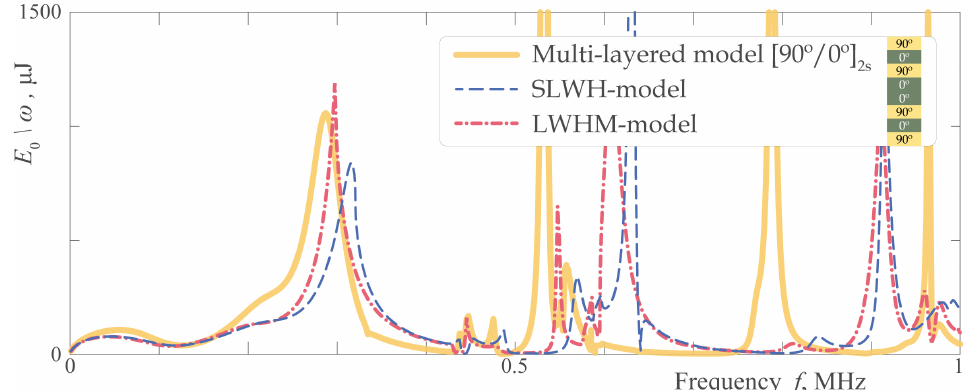
Figure 12. The wave energy transferred into the waveguide E 0 ( f ) by the PWT on the surface of multi- layered waveguide [ 90 ◦ ,0 ◦ ] 2s (thick solid line), and waveguides with effective properties estimated according to the SLWH-model (thin solid line) and the LWHM-model (dash-dotted